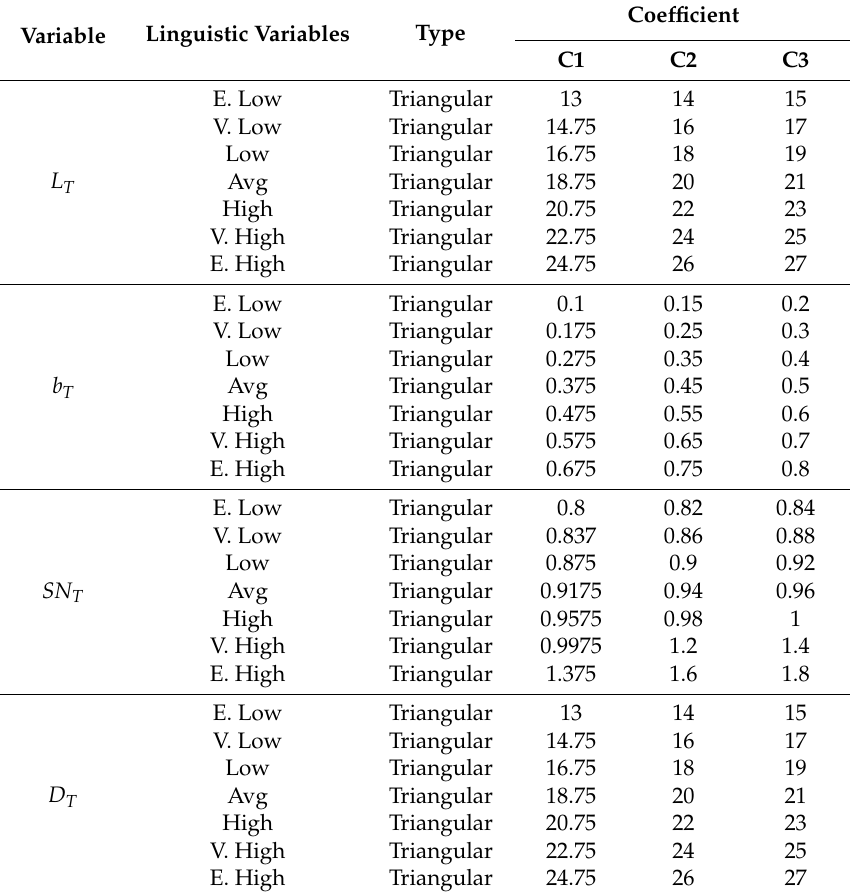
Table 4. Coefficients of membership functions for